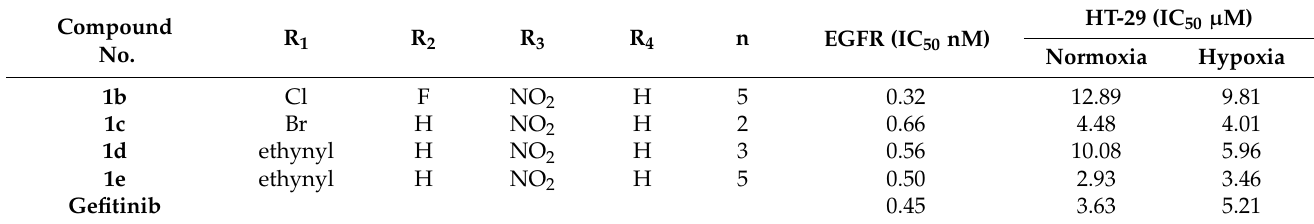
Figure 2. Structure of quinazoline ‐ based imidazole hybrids and the most promising compound 1a . Table 1. In vitro cytotoxic activities of hybrid compounds 1 ( b – e ). Table 1. In vitro cytotoxic activities of hybrid compounds 1 ( b – e ).